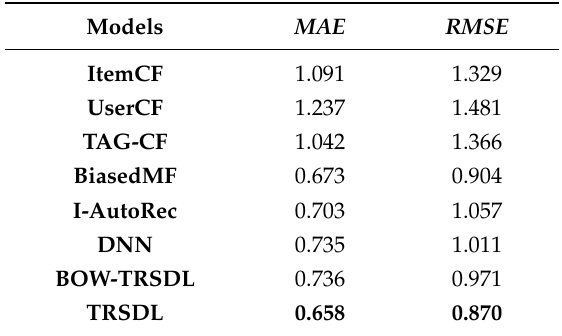
Table 5. The comparison of MAE and RMSE values for the